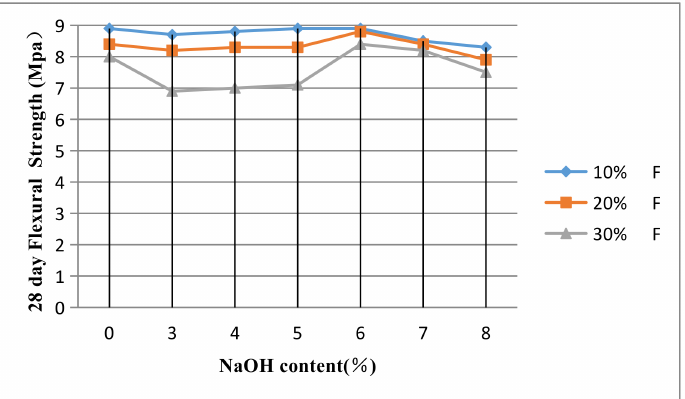
Figure 4. NaOH content–flexural strength curves at 28 days.